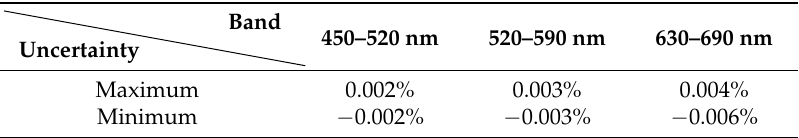
Table 4. Maximum and minimum value of σ i induced by seawater salinity measurement errors in the 22 samples.